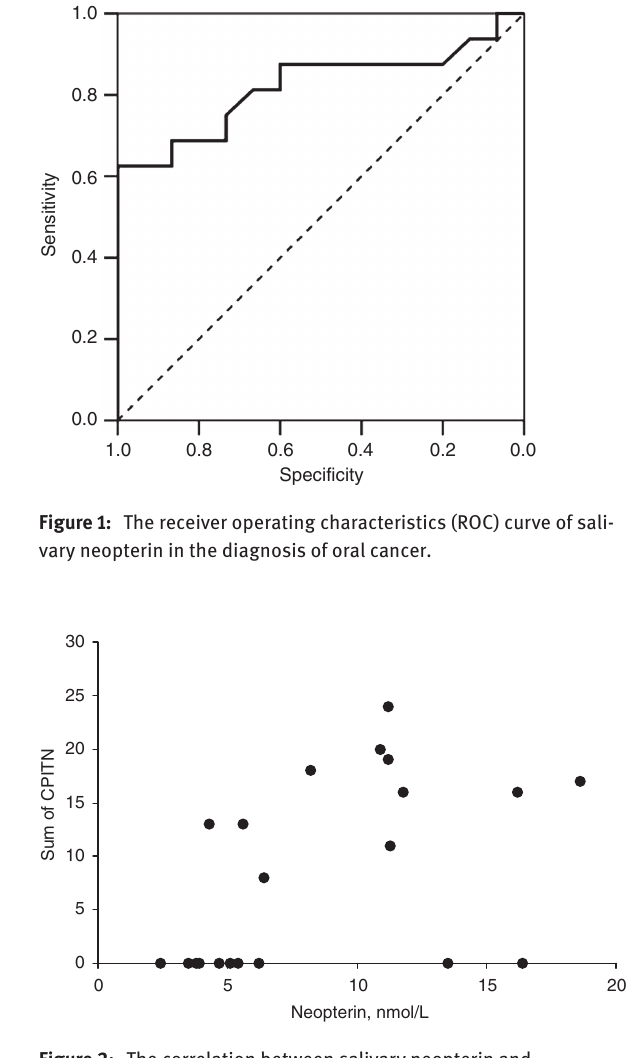
of neopterin in the saliva of patients with cancers of the oral